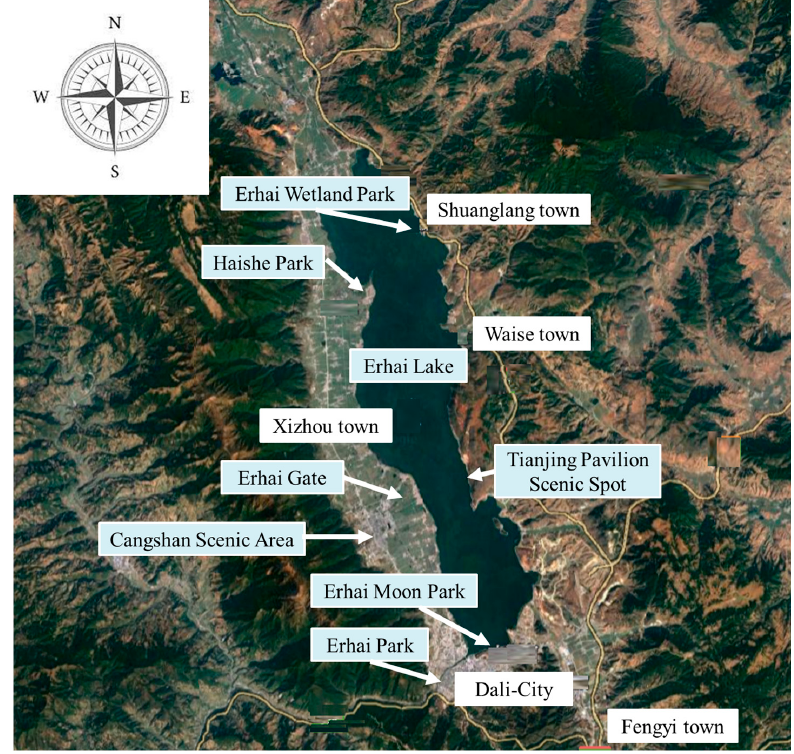
Figure 1. Erhai Lake catchment area and surrounding villages.